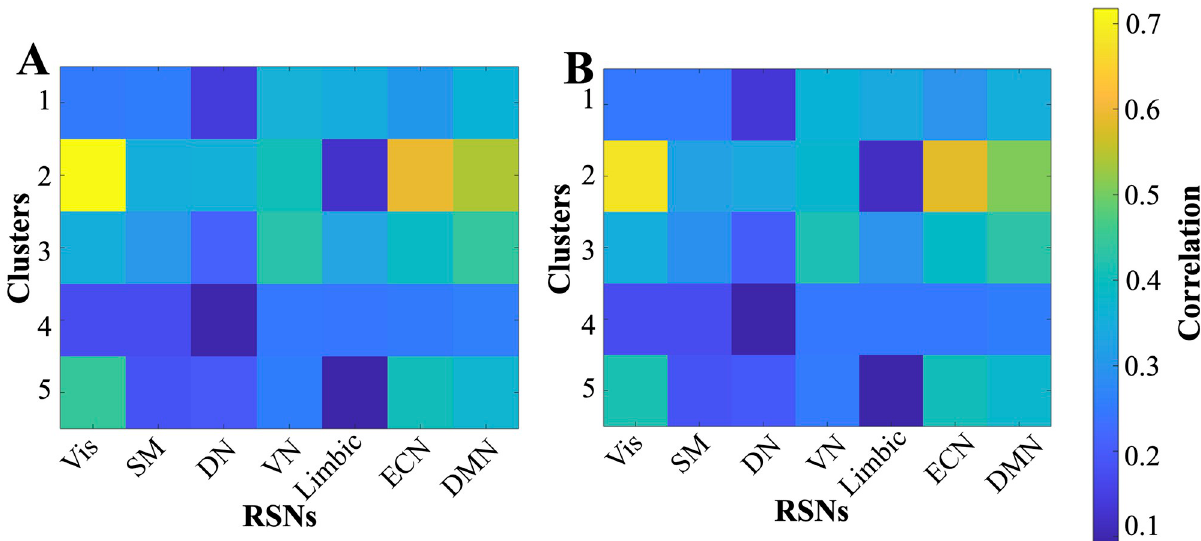
Fig 10. Similarity between eigenvector centroid of the clusters and RSNs. (A-B) denotes the spatial correlation between clusters and resting state networks before and after ARFIMA filtering on the resting-state BOLD data, respectively. The colorbar depicts the correlation values for both panels.